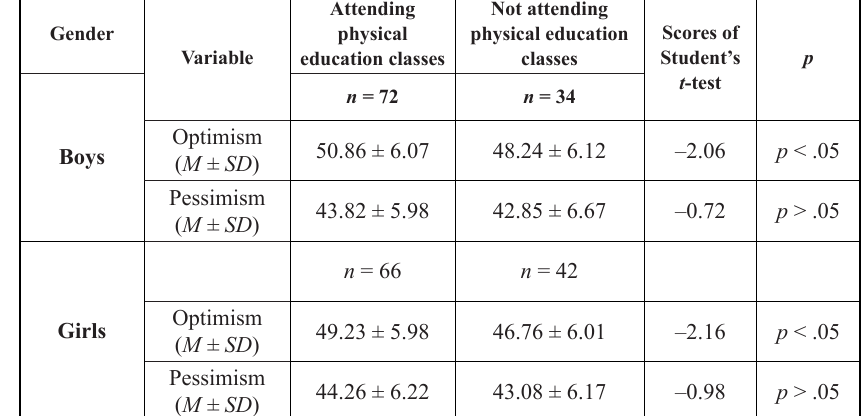
Table 1. The statistical indicators of the optimism expression among boys and girls attending and not